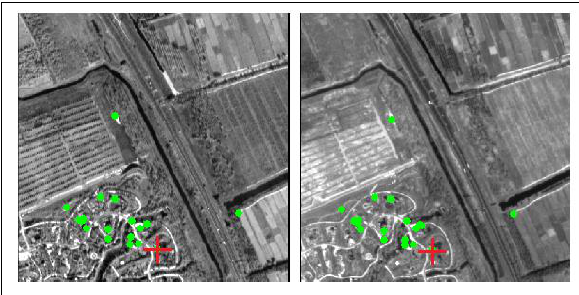
6 ground control points and 54 tie points are selected in this experiment. The red point is the ground control point in Figure 1. The blue point is the tie point in Figure